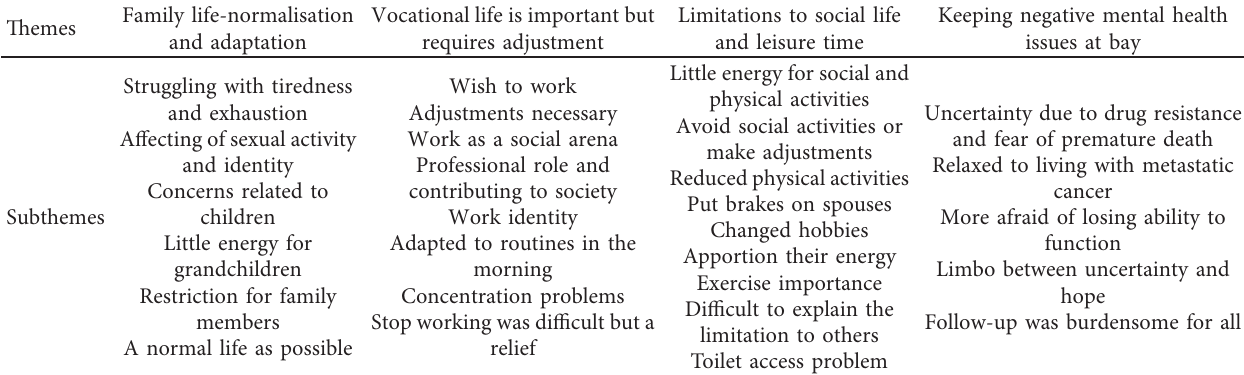
Table 2: Themes extracted from the participants